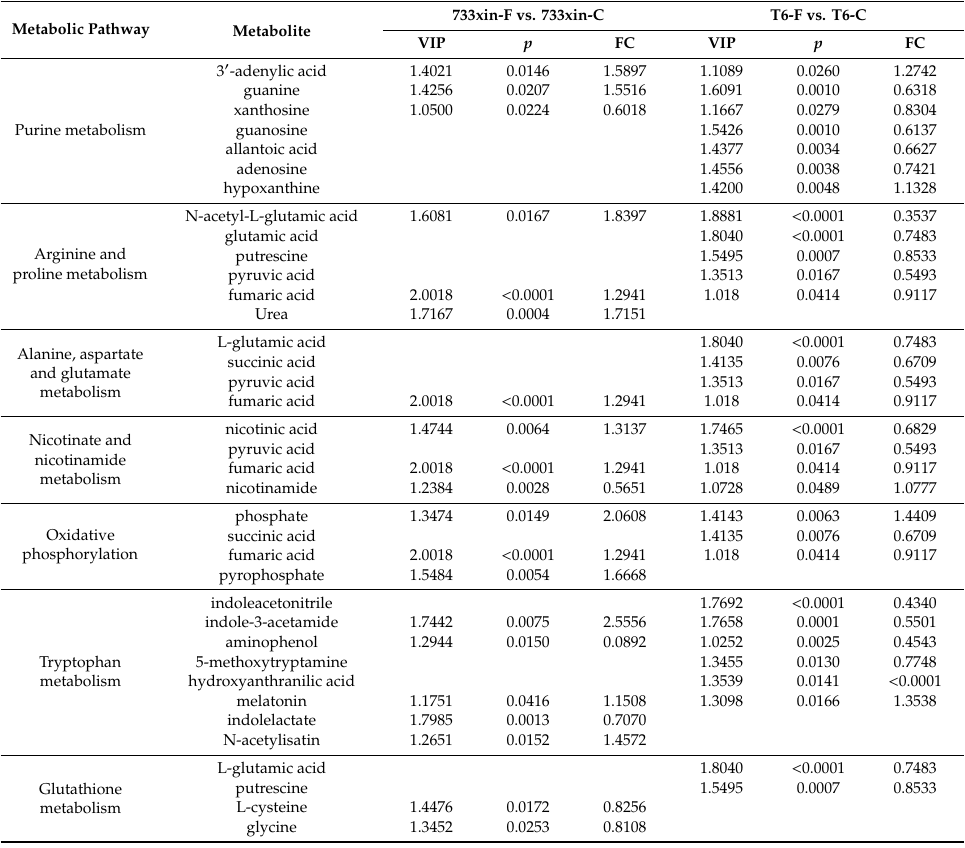
Table 2. Partial identified di ff erential metabolites of T6_F vs. T6_C and 733xin_F vs. 733xin_C. Metabolic